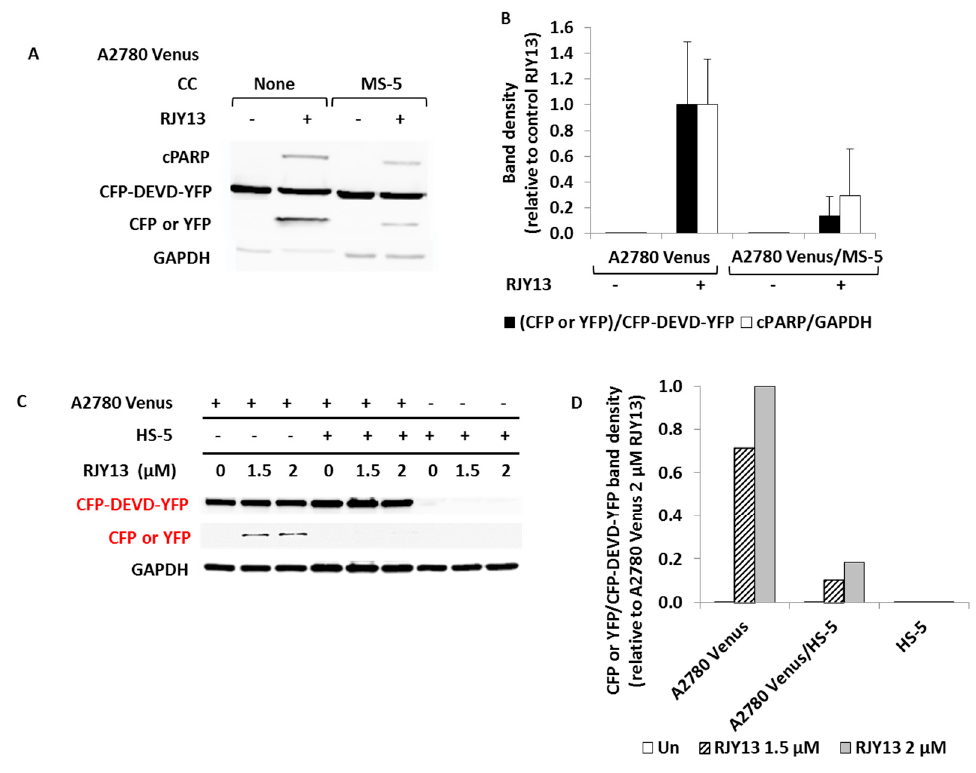
Figure 2. HS-5 cells confer drug resistance to OC cells. OC cisplatin sensitive cells carrying pECFP-DEVDR-Venus plasmid (A2780 Venus) cells were co-cultured with MS-5 ( A , B ) or HS-5 ( C , D ) and exposed to 5 µ M RJY13 or 1.5 or 2 µ M RJY13, respectively. Levels of cleaved CFP / YFP (CFP or YFP, A , C ) and cleaved human PARP (cPARP, A ) were determined by immunoblotting ( A , C ). Relative cPARP levels as well relative levels of cleaved CFP were calculated and plotted ( B , D ). GAPDH was used as a loading control. CC, co-culture.